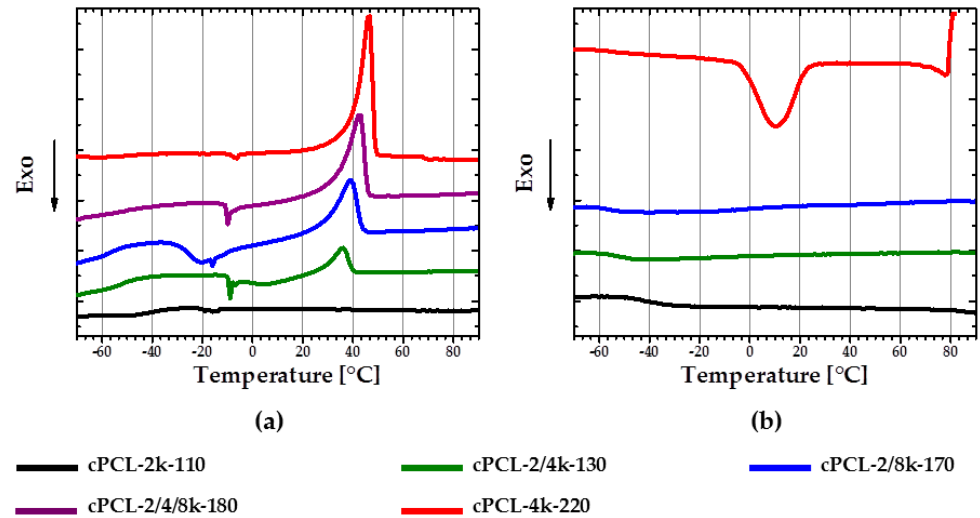
Figure 5. ( a ) Differential scanning calorimetry (DSC) second heating; and ( b ) DSC first cooling curves of polyurethane foams with different polyol chain lengths. Heating and cooling rates were 3 K ∙ min − 1 .